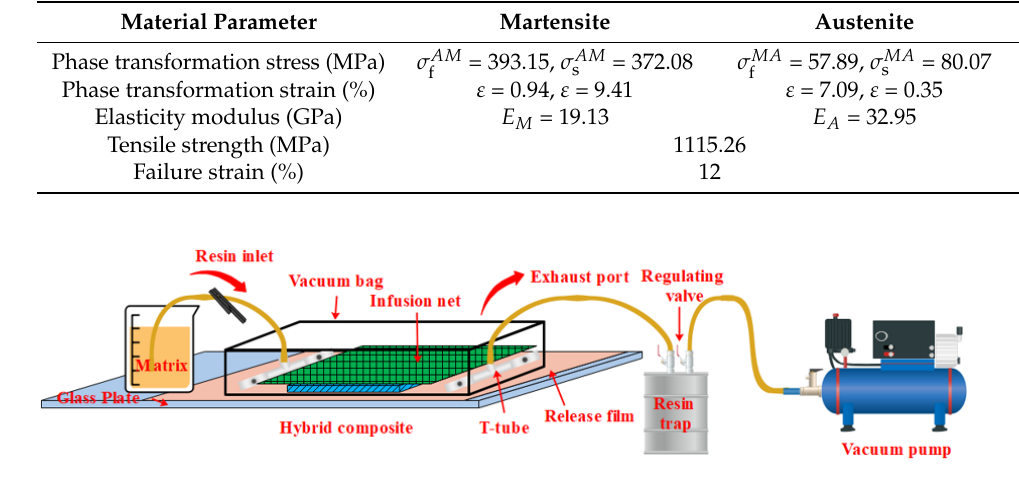
Figure 2. Illustration of VARI.